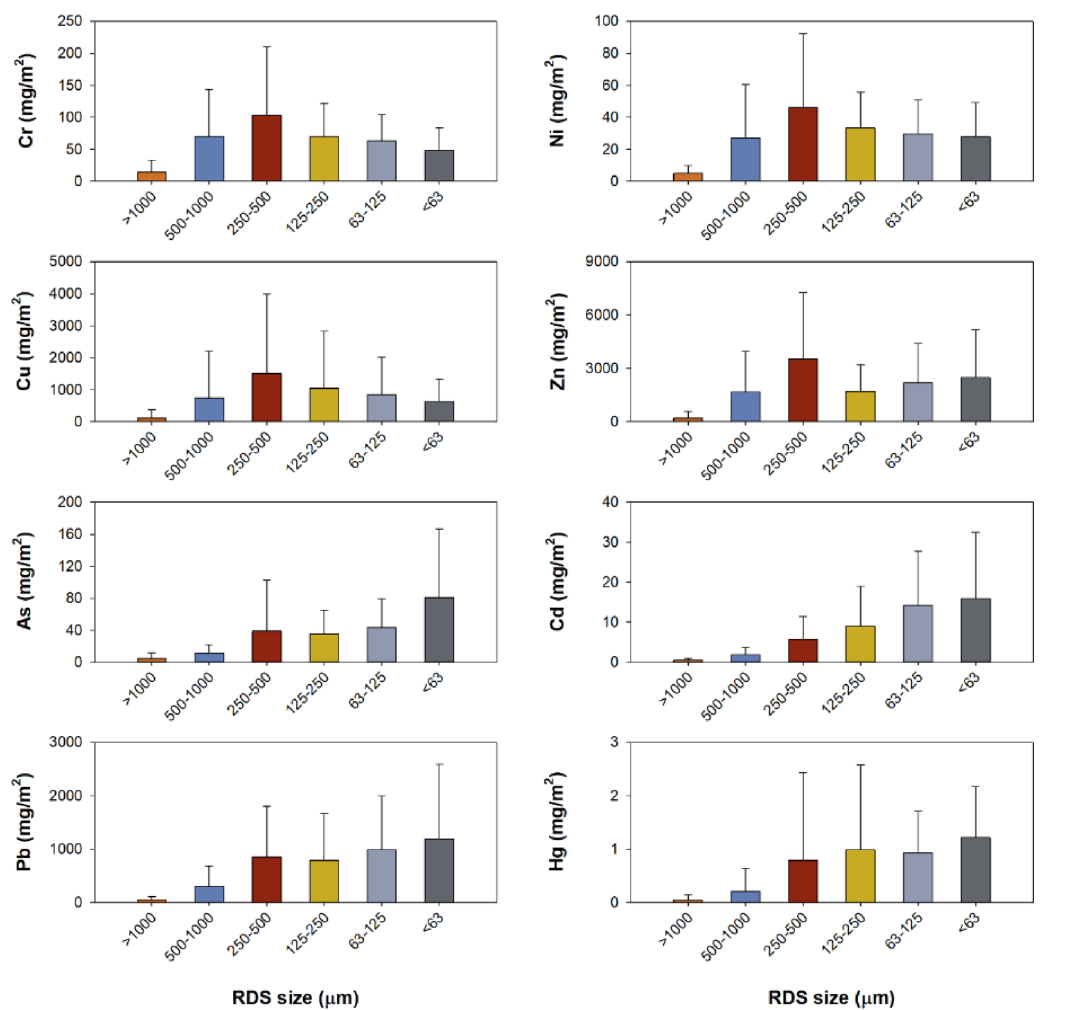
Figure 5. Comparison of mean PTEs loads (mg/m 2 ) with standard deviation in the different sizes of road deposited sediments of this